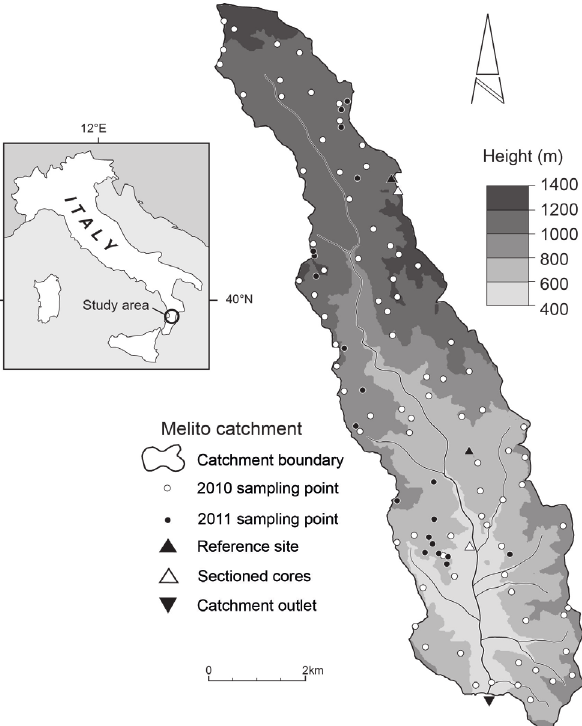
Fig. 1 The study catchment and the soil sampling